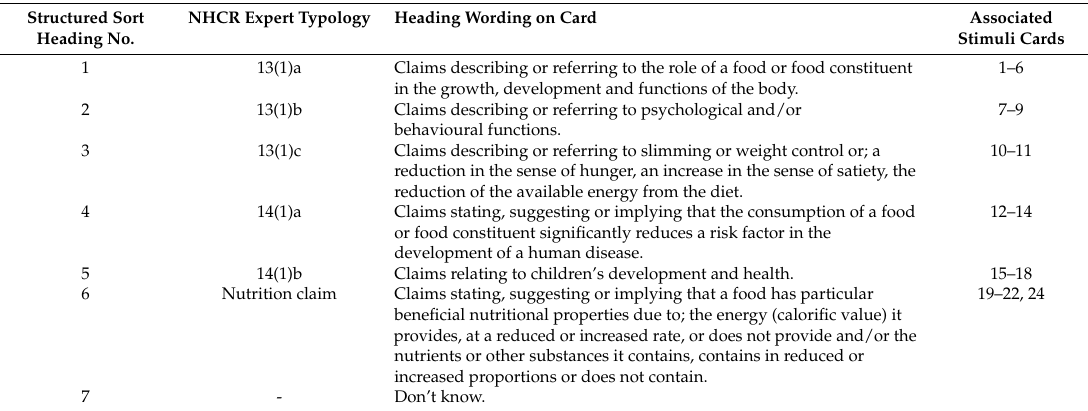
Table 3. Structured sort headings and associated stimuli